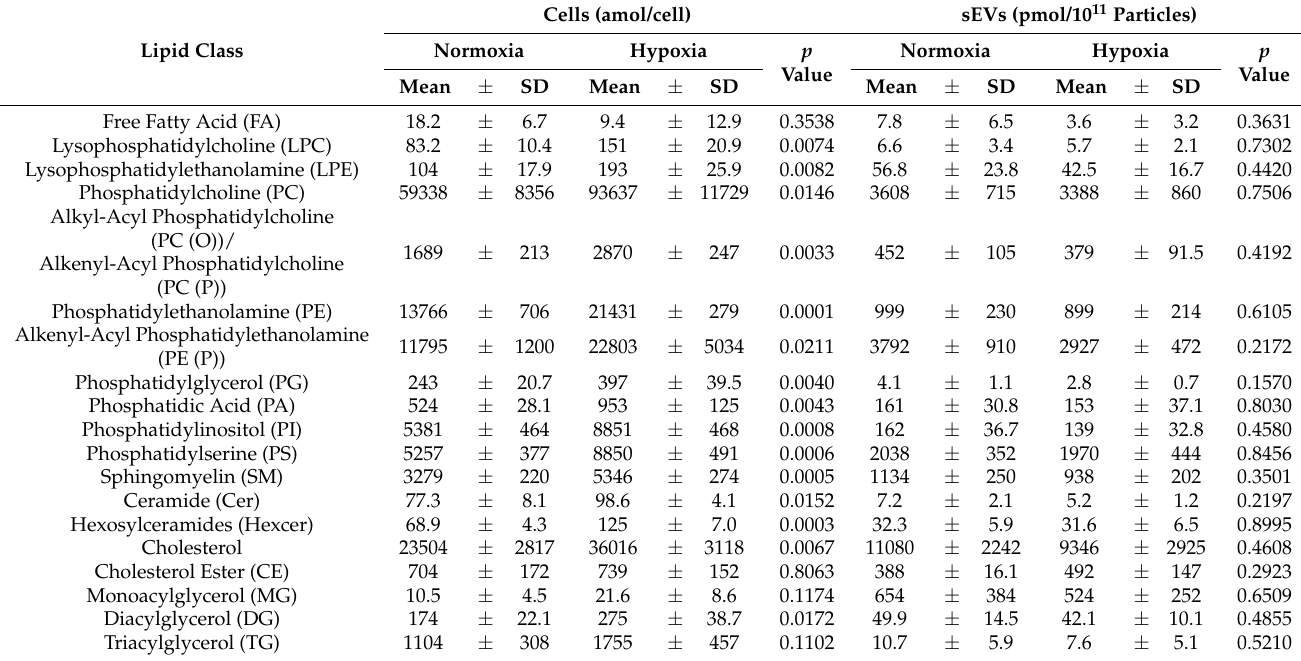
Table 3. Lipid content in cells and small extracellular vesicles (sEVs) under different oxygen conditions.